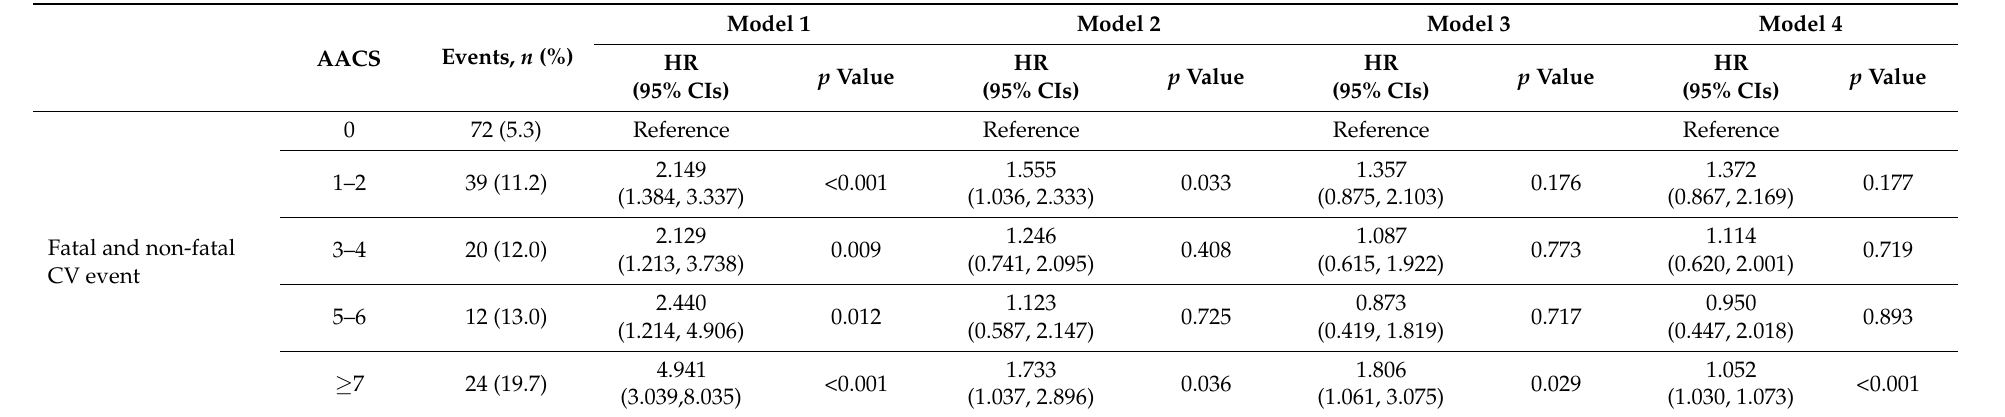
Table 3. Cox regression analysis of AACS for the secondary